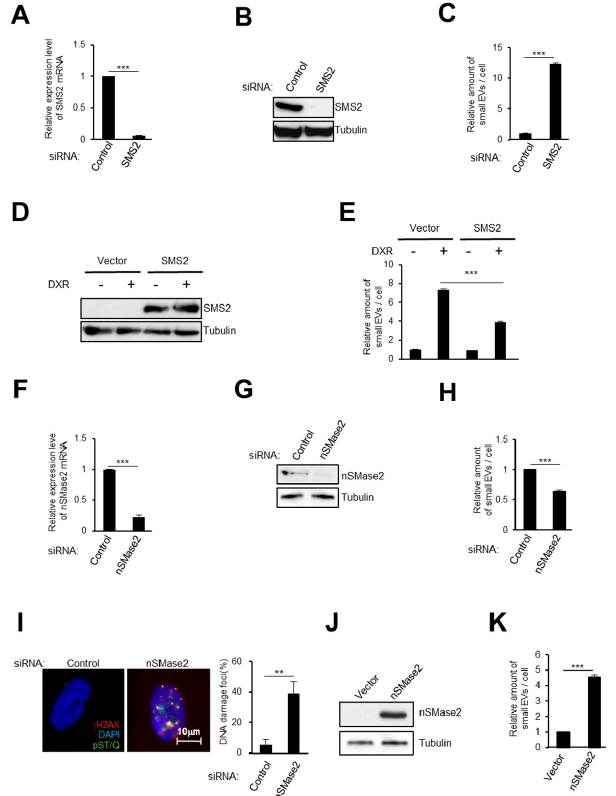
Figure 2. The ceramide pathway plays an important role in small EV secretion from HDFs. ( A – C ) After transfection with siRNA oligos against SMS2 twice, TIG-3 cells were then subjected to RT-qPCR analysis of SMS2 gene expression ( A ), western blotting ( B ), or to NanoSight analysis of isolated small EV particles ( C ). ( D , E ) After infection with retrovirus encoding FLAG-tagged SMS2 or empty vector and selection with puromycin, TIG-3 cells were treated with 150 nM DXR for 10 days and subjected to western blotting ( D ), or to NanoSight analysis of isolated small EV particles ( E ). ( F – H ) After transfection with siRNA oligos against nSMase2 twice, TIG-3 cells were subjected to RT-qPCR analysis of nSMase2 gene expression ( F ), western blotting ( G ), NanoSight analysis of isolated small EV particles ( H ), and to immunofluorescence staining for markers of DNA damage ( γ -H2AX [red], pST / Q substrate [green] and DAPI [blue]) ( I ). The percentage of nuclei that contain more than 3 DNA damaging foci positive were shown in the histograms ( I ). ( J , K ) Pre-senescent TIG-3 cells were infected with retrovirus encoding FLAG-tagged nSMase2 or empty vector. After selection with puromycin, cells were subjected to western blotting ( J ), or to NanoSight analysis of isolated small EV particles ( K ). For all graphs, error bars indicate mean + standard deviation (s.d.) of triplicate measurements. P values was calculated